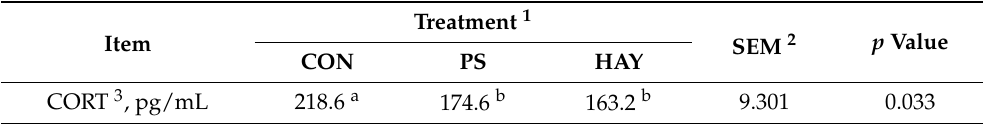
Table 4. Means of serum corticosterone concentration in laying hens according to environmental enrichment materials.